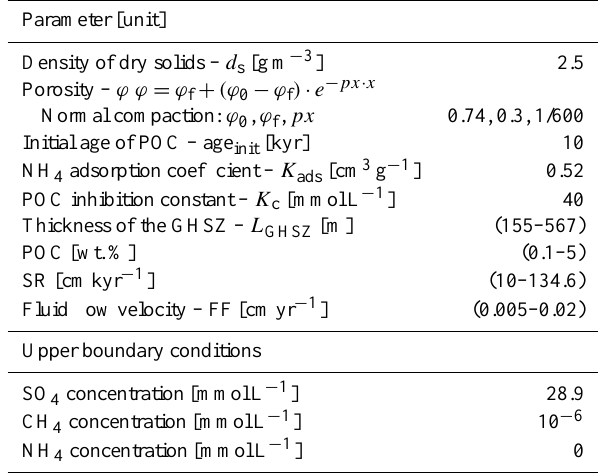
Table 3. Input parameters and upper boundary conditions for the standard model.